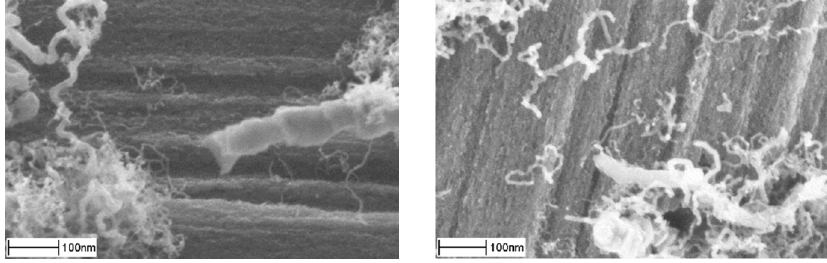
Figure 6. Typical CNF attachments to the fibers, after acetone solution.